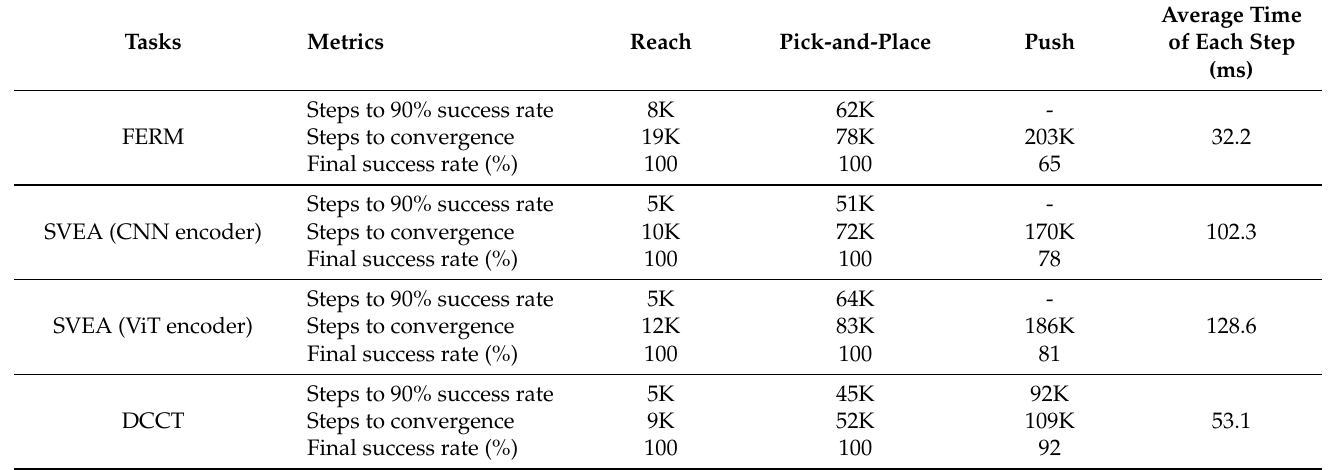
Table 1. Performance comparison in robotic manipulation. Task success rates of FERM, SVEA (CNN en- coder), SVEA (ViT encoder), and Our method in the three simulated robotic manipulation environments, with ten expert demonstrations. Mean of 25